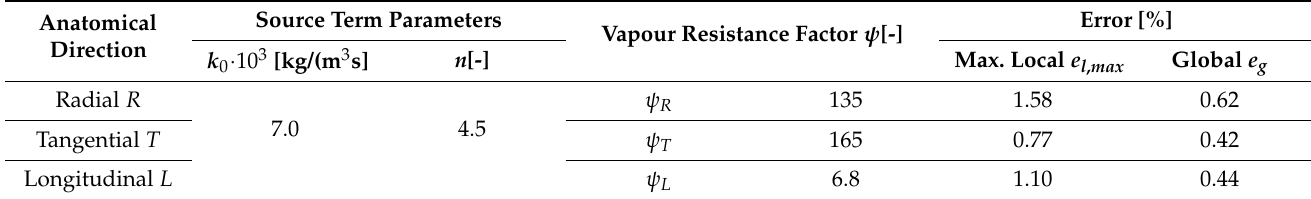
Table 6. Model coefficients and matching errors for